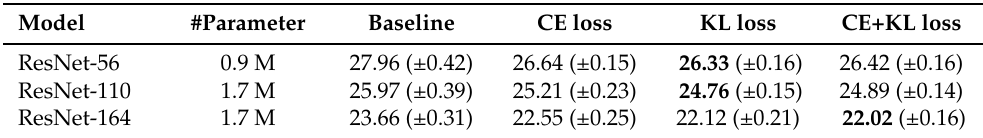
Table 4. Test error rate comparison on CIFAR-100 [26] with different loss setting (mean ( ± standard deviation), in %).